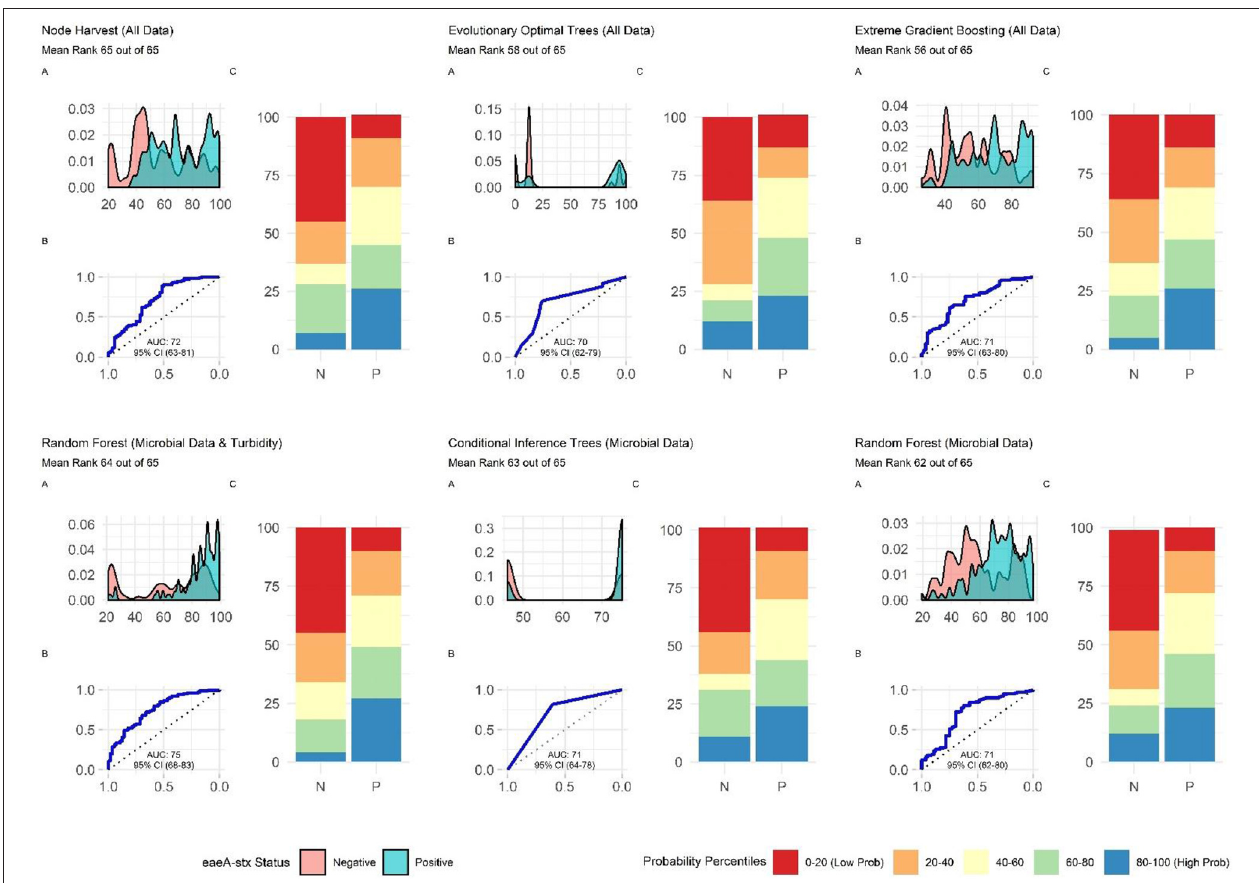
FIGURE 8 | Plots showing the performance of the top-ranked full and nested eaeA-stx models. (A) Shows how well the model can distinguish samples that tested positive and negative for eaeA-stx . The x-axis of (A) is the probability of eaeA-stx detection generated by the model, and the y-axis is density. (B) Is the receiver-operating curve (ROC) for the model; the x-axis is 1-Specificity and the y-axis is Sensitivity. (C) Shows how well the model is at accurately classifying positive and negative samples. The split quantiles plot is generated by sorting the test data from lowest to highest probability of eaeA-stx detection based on the given model. The test data is then divided into quantiles (based on the percentile the probability falls into). The proportion of samples in each quantile that were actually eaeA-stx -positive or negative were plotted. A good model would identify all low probability percentile samples (red) as negative (N) and all high probability percentile samples (blue) as positive (P). ranking models based on performance ( Supplementary Table 3 ; Figure 8 ). While all nested models performed worse than the